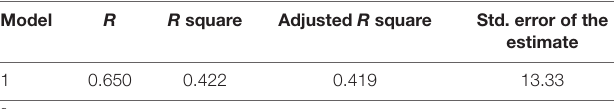
TABLE 4 | Model summary for psychological well-being, loving pedagogy, work engagement. Model